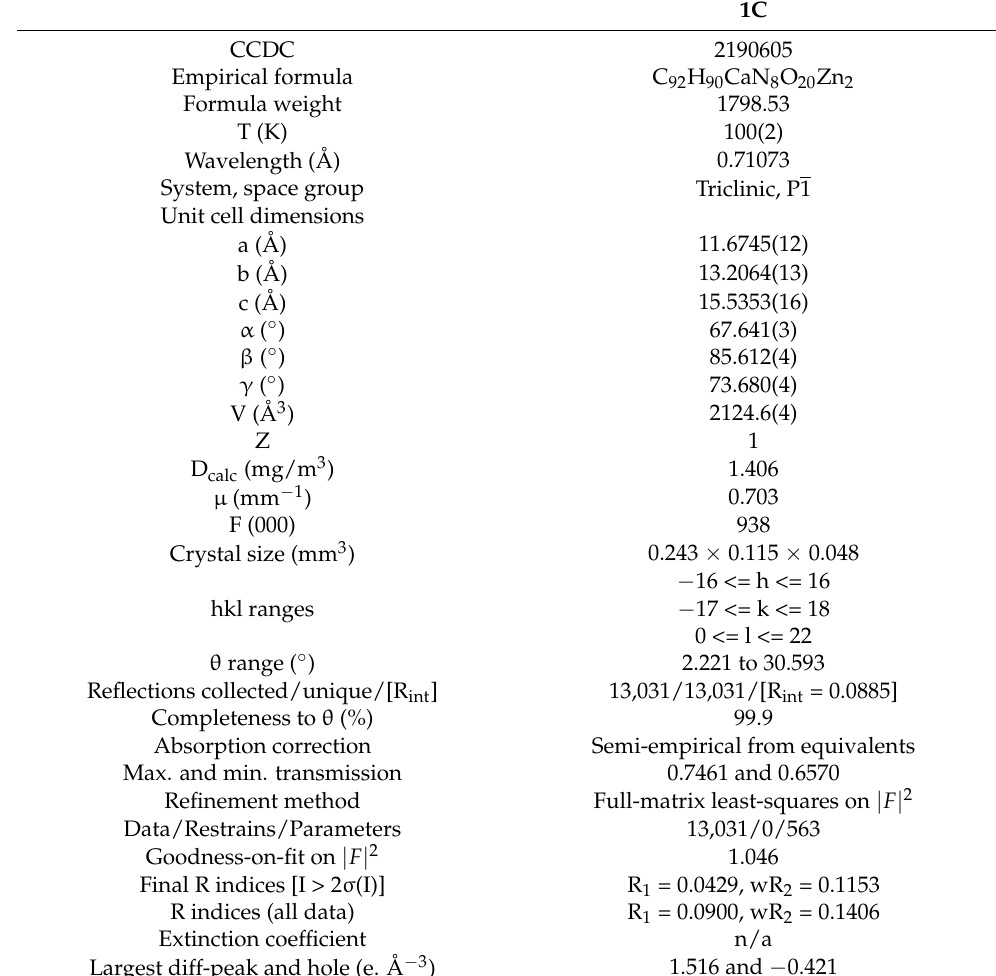
Table 1. Crystal data and structure refinement for 1C